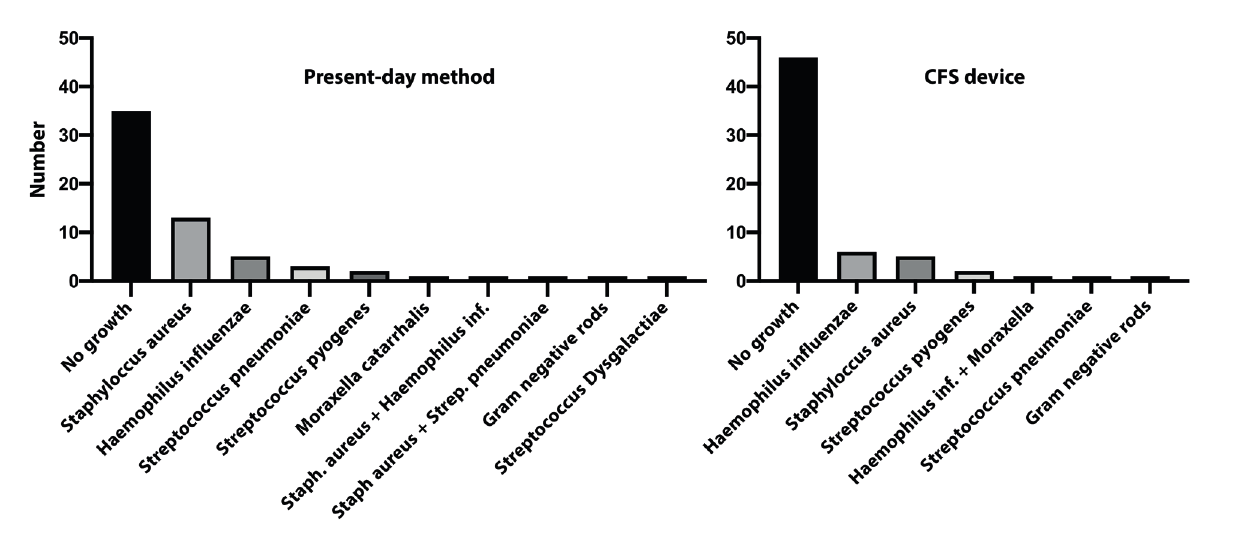
Figure 2. Staphylococcus aureus was the most frequently grown bacterium using the present-day technique whereas it was the 2nd most commonly grown bacterium using the CFS device. Hemophilus influenza , Moraxella catarrhalis and Streptococci made up the majority of the other pathogens in cultures. CFS = contamination-free